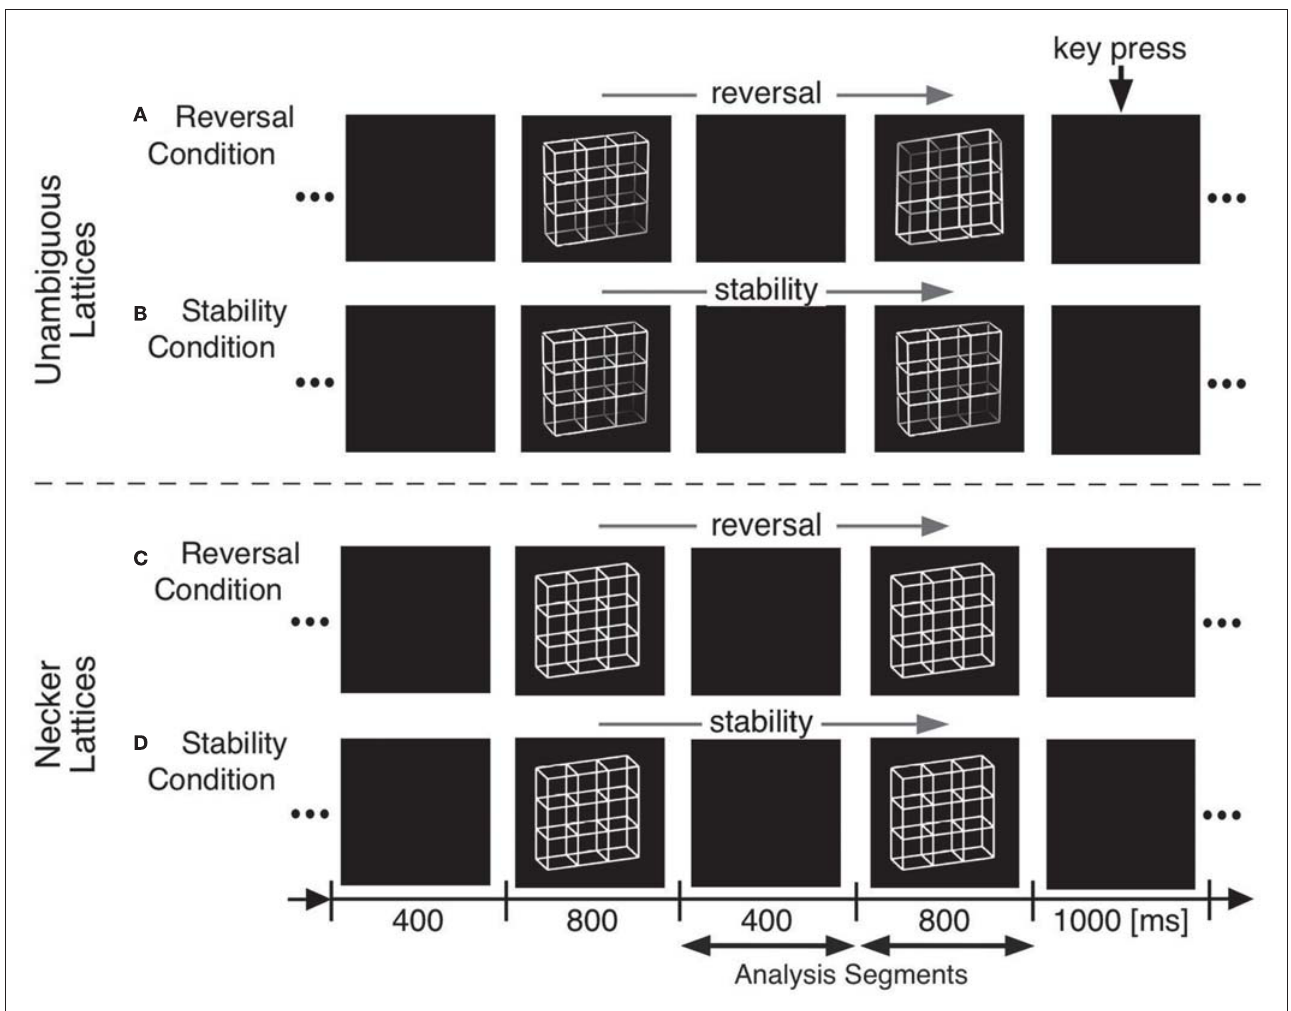
perspective reversal [reversal conditions in (A,C) ] or perceived stability [stability conditions in (B,D) ] across two successive stimulus presentations by a key press in the ISI following the respective perceptual event. Each key press extended the current ISI from 400 to